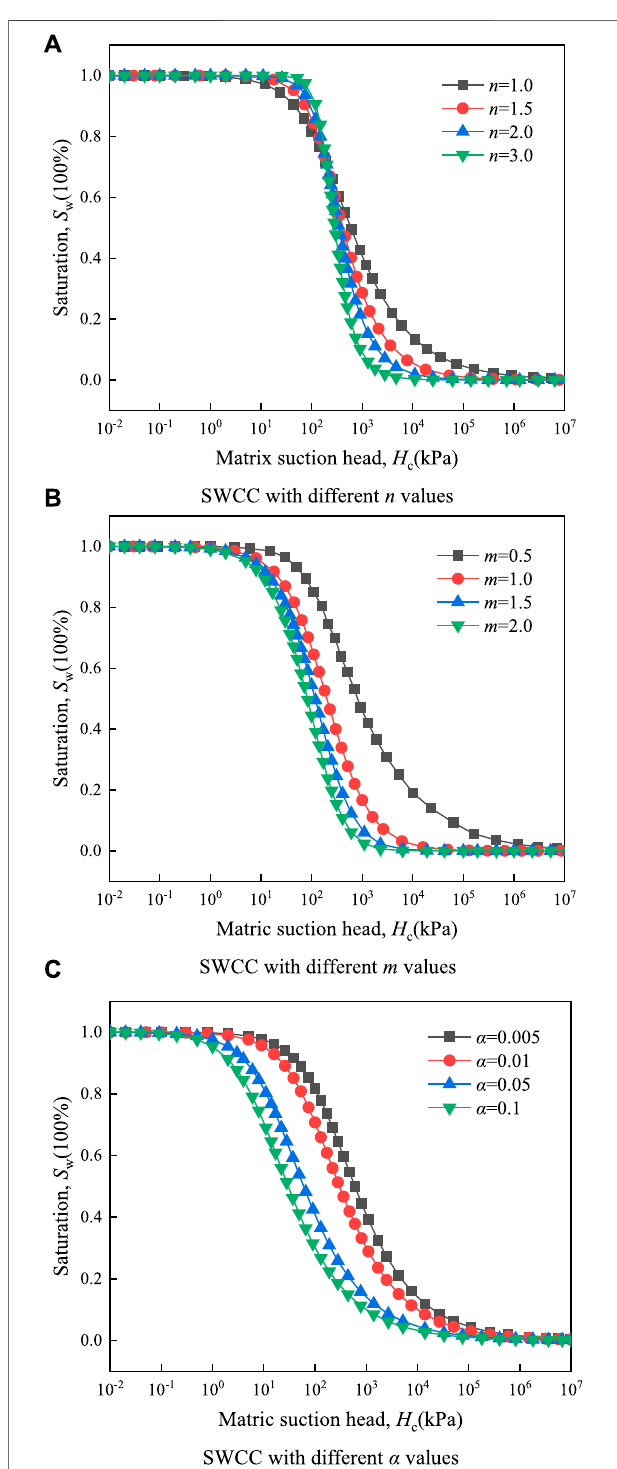
FIGURE 3 | SWCC of unsaturated soil with different parameter